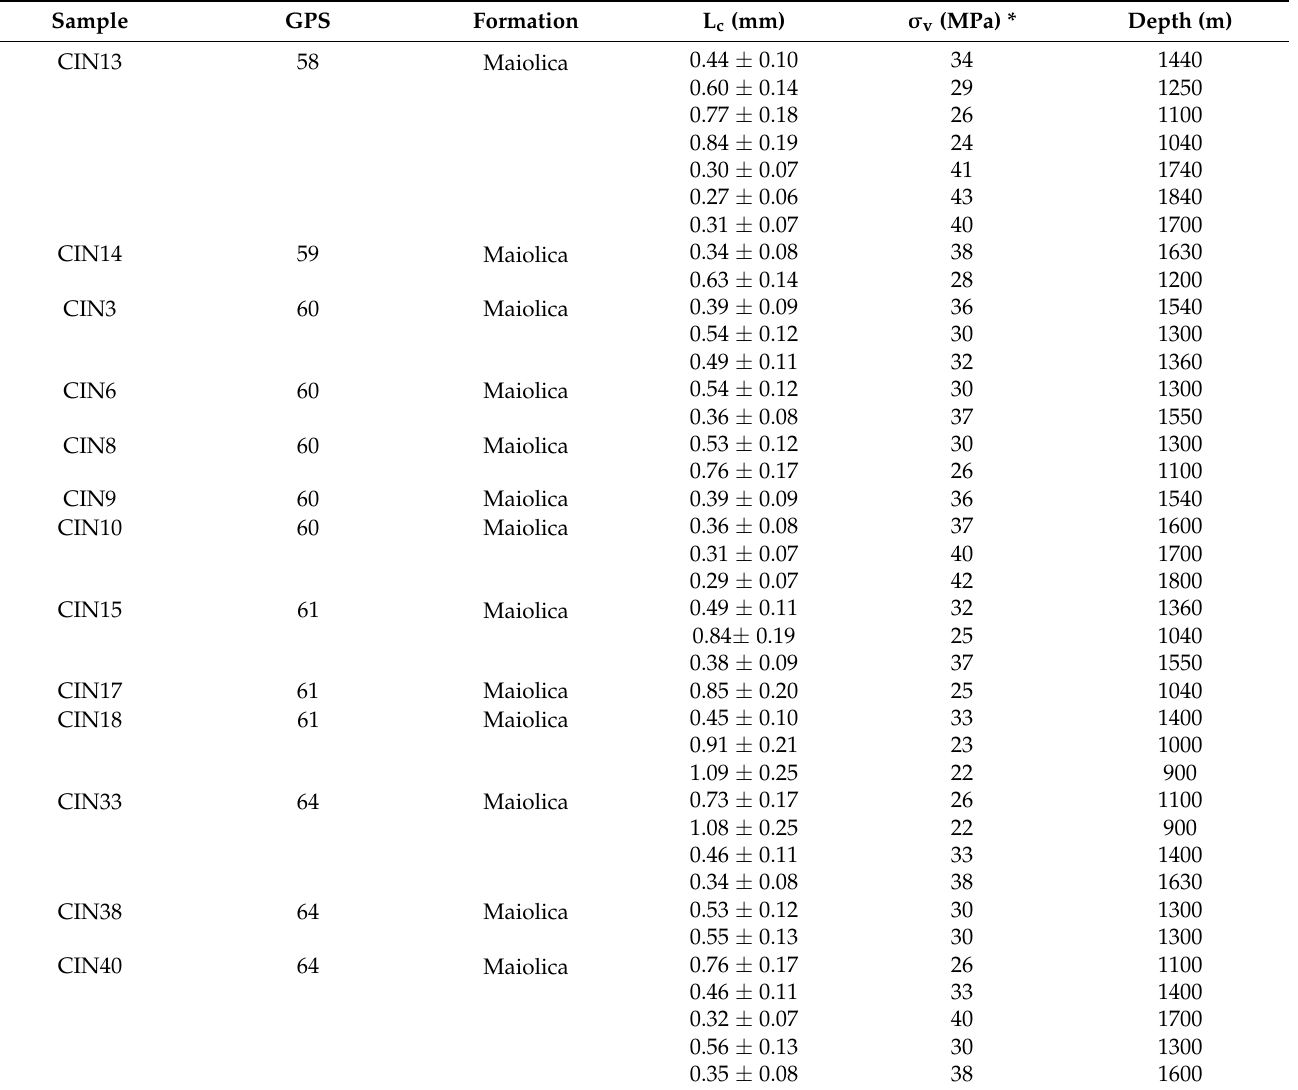
Table 1. Results of stylolite roughness inversion, applied on bedding-parallel stylolites.